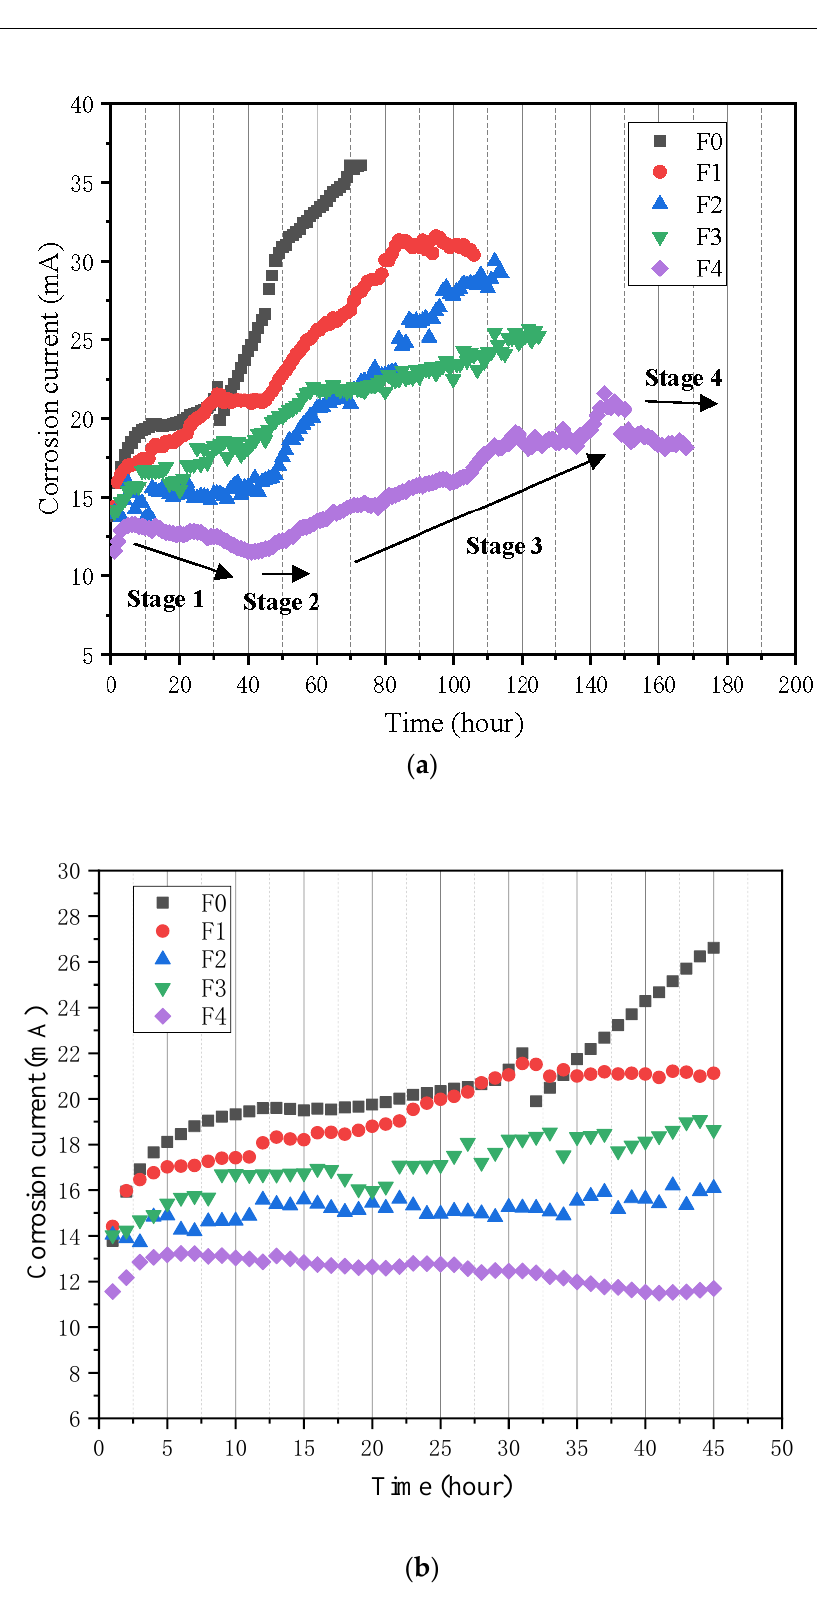
Figure 9. Corrosion current of 50% FA mortar: ( a ) the whole corrosion time and ( b ) the first 40 h corrosion time.